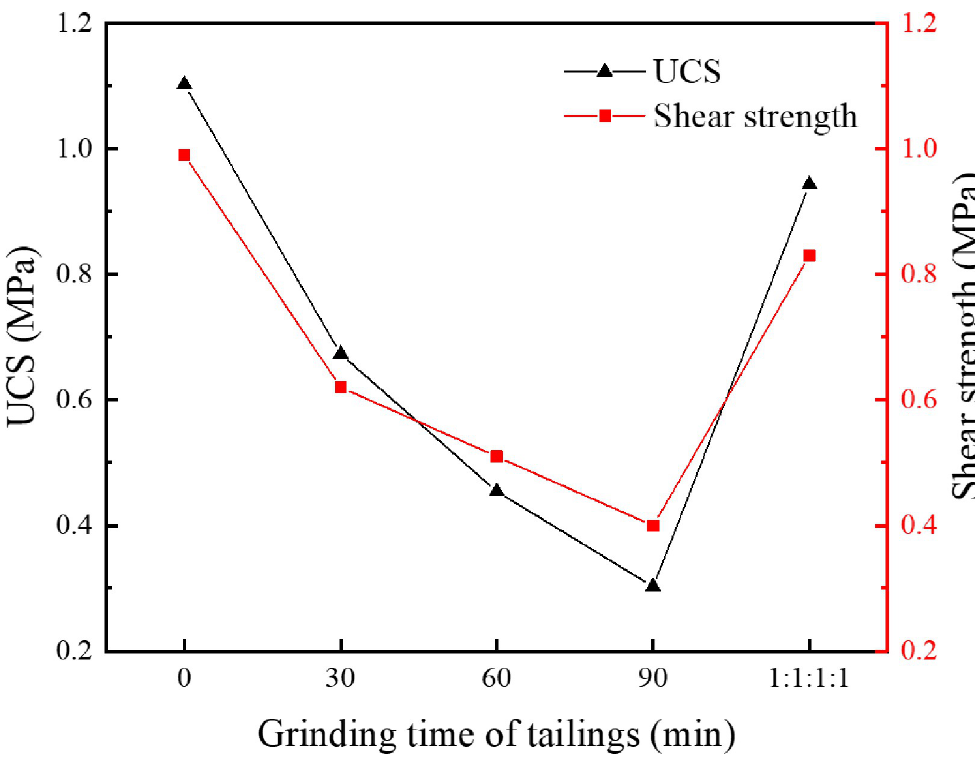
Fig 13. Relationship between tailings particle size and mechanical